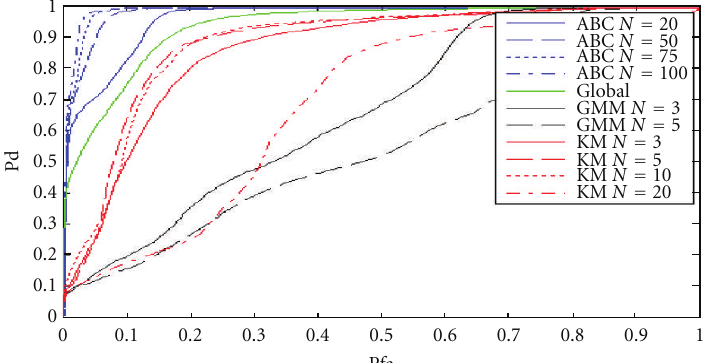
Figure 14: ROC curve performance testing QG-SemiP (ABC), global RX (global), k means (KM), and GMM detectors on scene shown in Figure